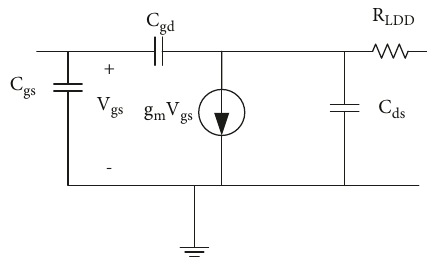
Figure 2: Equivalent circuit of RF